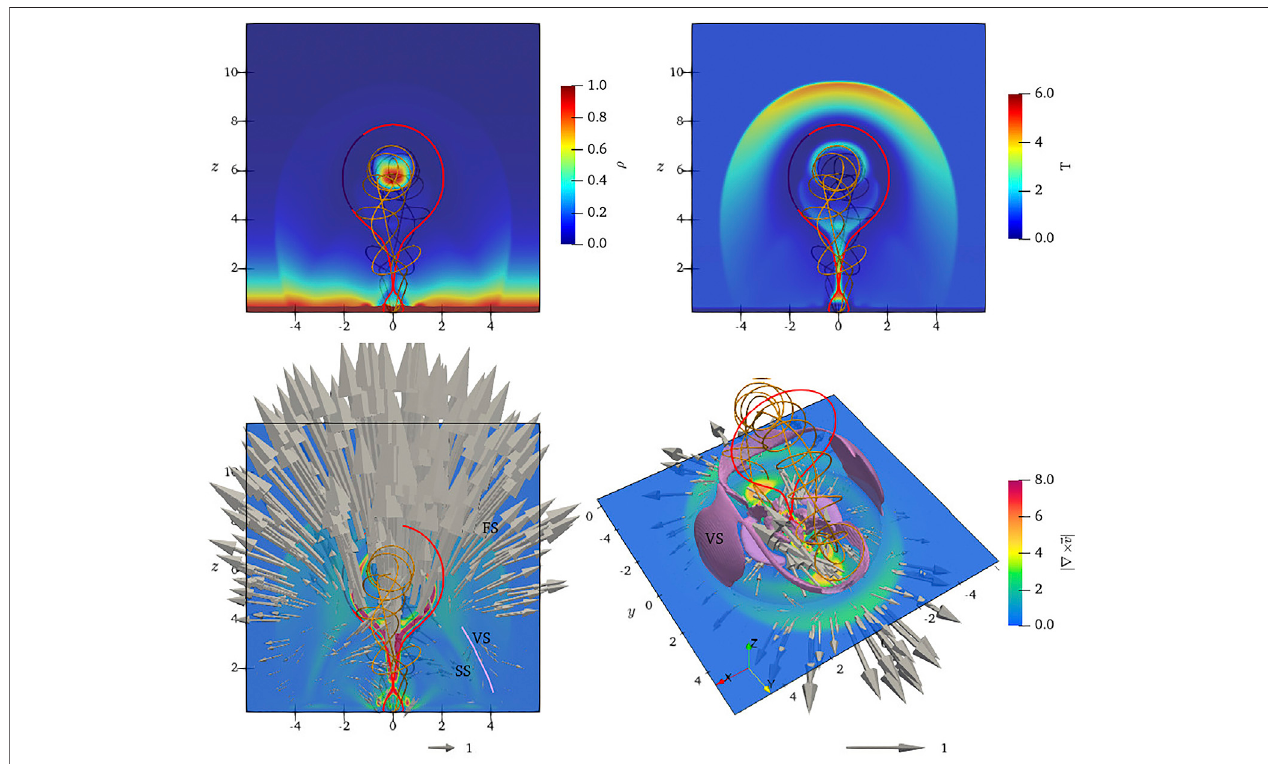
FIGURE2| Distributions(colouredshading)ofdensity ρ ,temperature T andvelocitycurl ∇ × (cid:2) v anddistribution(3Dyellowarrows)ofvelocityoncuts y (cid:2) 0and z (cid:2) z p at t (cid:2) 2.Thefastshock(FS),theslowshock(SS),andthevelocityseparatrix(VS)aremarkedonthepanels.Thegoldenandredcurvesaremagnetic fi eldlinesoftheMFR and the outer boundary of the CME bubble. The pink isosurface | v | (cid:2) 0.07 illustrates the 3D VS